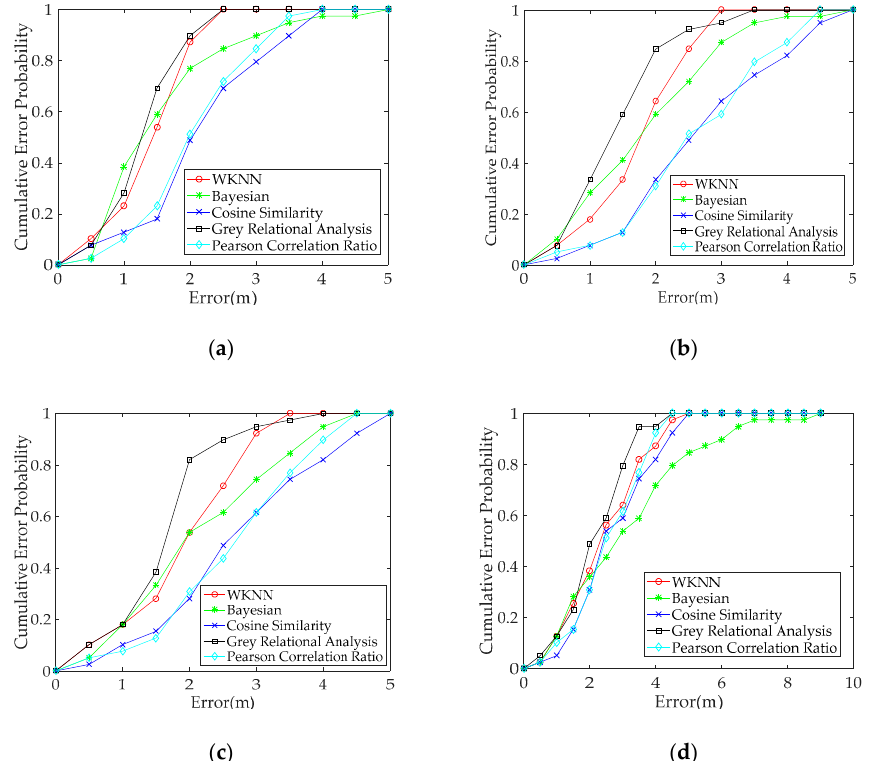
Figure 8. Comparison of positioning performance for di ff erent methods under heterogeneous and the same smartphones: Fingerprint data are collected with the Redmi 5plus smartphone in the o ffl ine phase, and the test data are collected with four di ff erent smartphones in the online phase: ( a ) Redmi 5plus, ( b ) Honor 9, ( c ) Redmi Note 3, and ( d ) Mi